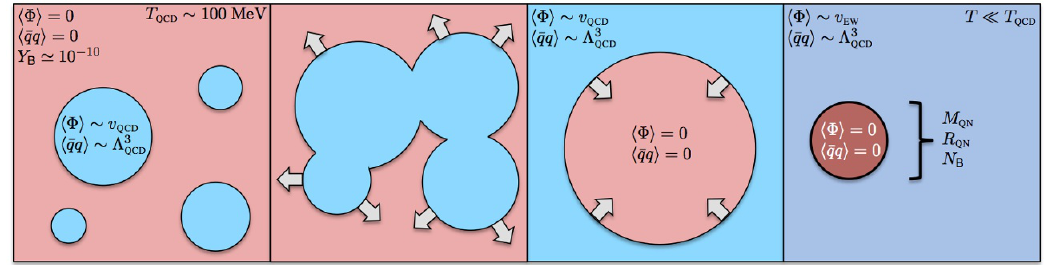
Figure 2 . A cartoon illustrating the cosmological dynamics leading to the formation of nuggets of six-(cid:13)avor quark matter. A (cid:12)rst-order QCD phase transition causes the baryon number to accumu- late into pockets of quark gluon plasma, which eventually cool to form 6FQM